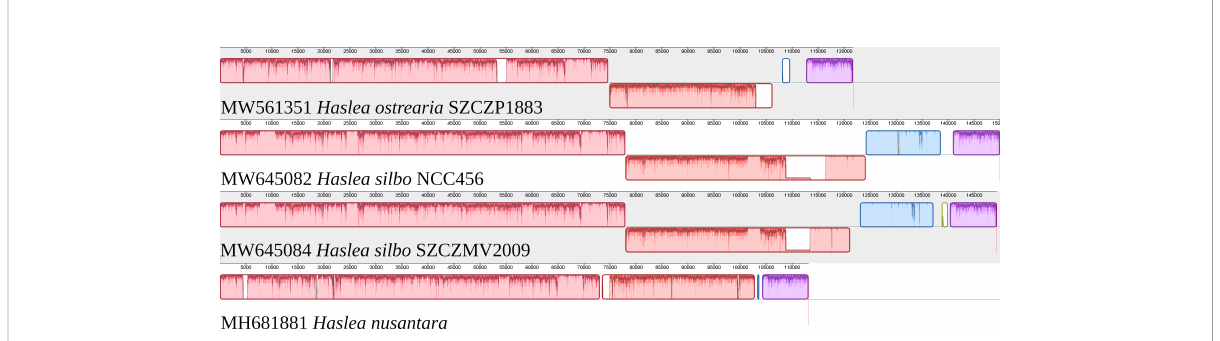
FIGURE 6 MAUVE alignment of the plastomes of Haslea ostrearia SZCZP1883, Haslea silbo and Haslea nusantara. There were 4 major blocks of synteny detected by MAUVE. The large single-copy corresponds to the fi rst pink block, and is colinear among all species. The short single-copy is divided into 3 main blocks of synteny. The red block corresponds to a cluster of genes delimited by ycf35 and clpC , which is on the negative strand for H. ostrearia and H. silbo , and on the positive strand for H. nusantara . The blue block is almost entirely lacking in H. nusantara , and mostly corresponds to DNA of plasmid